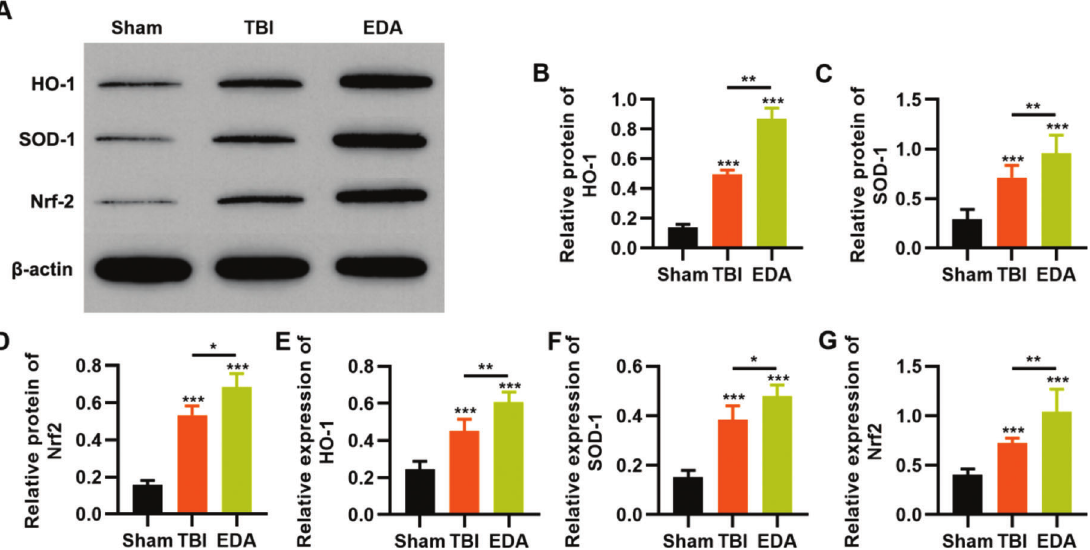
Figure 5 - Edaravone (EDA) upregulates the in vivo expression of Nrf2/ARE signal pathway in traumatic brain injury (TBI) rats. A–C, Results of Western blotting indicated that EDA could upregulate the protein content of heme oxygenase 1 (HO-1) (A), superoxide dismutase-1 (SOD-1) (B), and Nrf2 (C) in TBI rats; D–F, quantitative real-time polymerase chain reaction results indicated that EDA could upregulate the mRNA content of HO-1 (D), SOD-1 (E), and Nrf2 (F). * p o 0.05, ** p o 0.01, *** p o 0.001. Mann–Whitney U test.